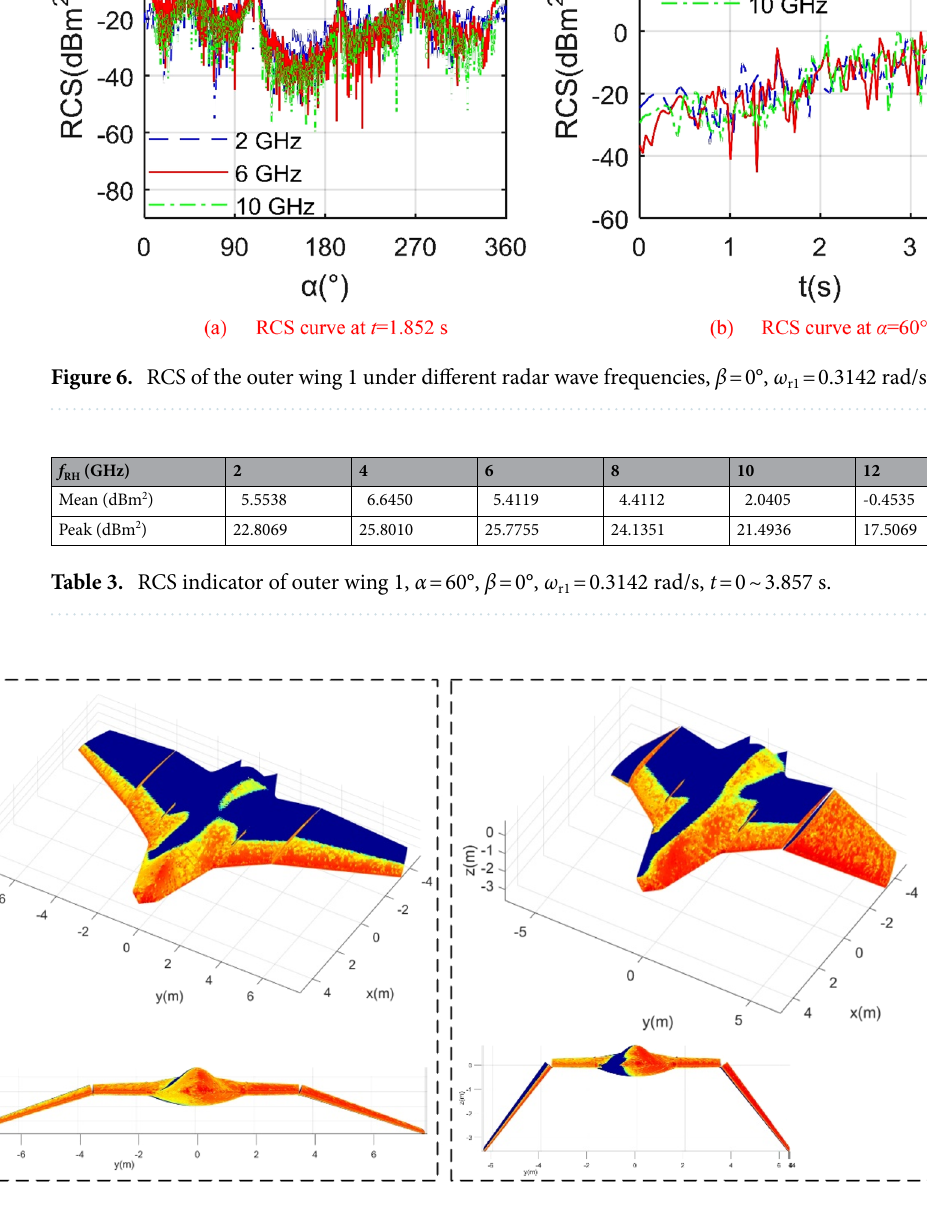
intensity of the end face of the mid wing is also increased. These results show that the HGMT method is feasible and intuitive to describe the electromagnetic scattering characteristics of the variant aircraft when the wings are folded. Figure 8 indicates that the dynamic RCS curve of the aircraft under different azimuth angles is quite different, including the fluctuation range, peak size, peak number and change trend. For the RCS curve at α = 10°, the curve has small fluctuations between − 12.97 and − 6.186 dBm 2 , because the strong scattering sources on the aircraft